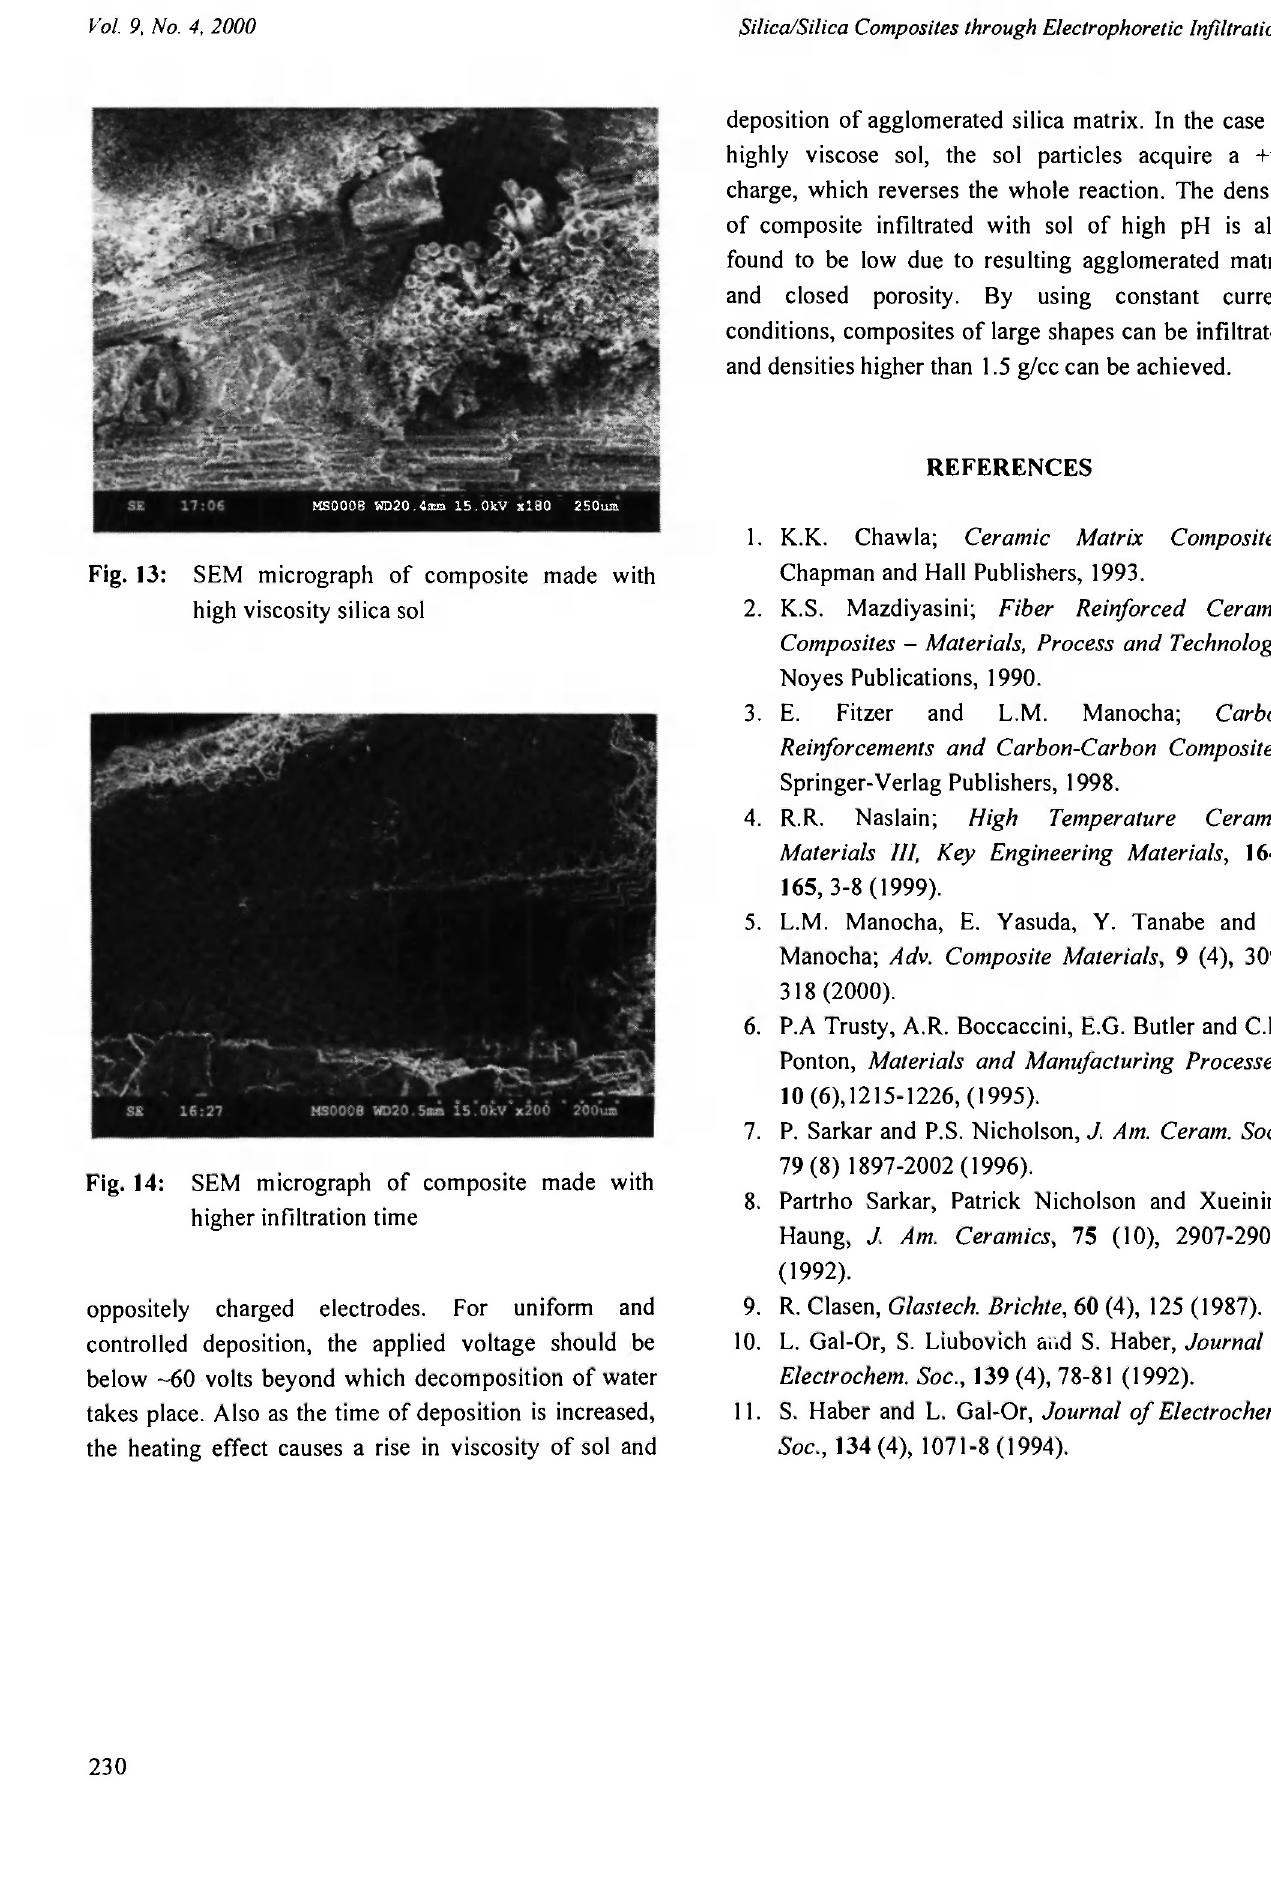
oppositely charged electrodes. For uniform and controlled deposition, the applied voltage should be below -60 volts beyond which decomposition of water takes place. Also as the time of deposition is increased, the heating effect causes a rise in viscosity of sol